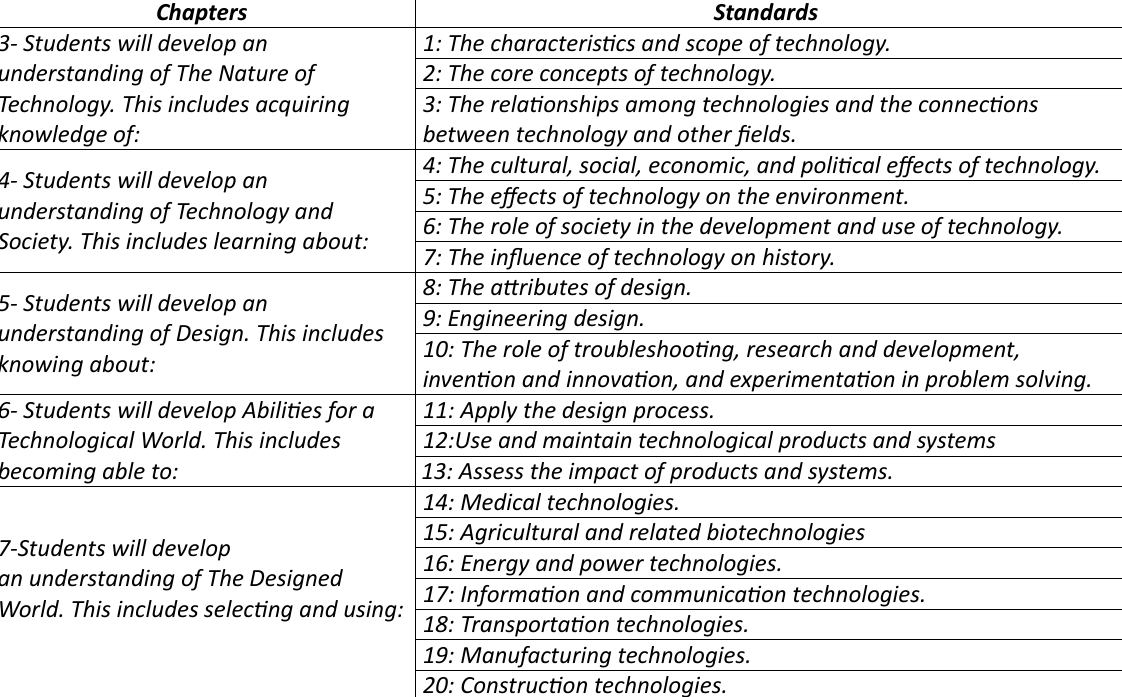
Table 2. Listing of Standards for Technological Literacy in